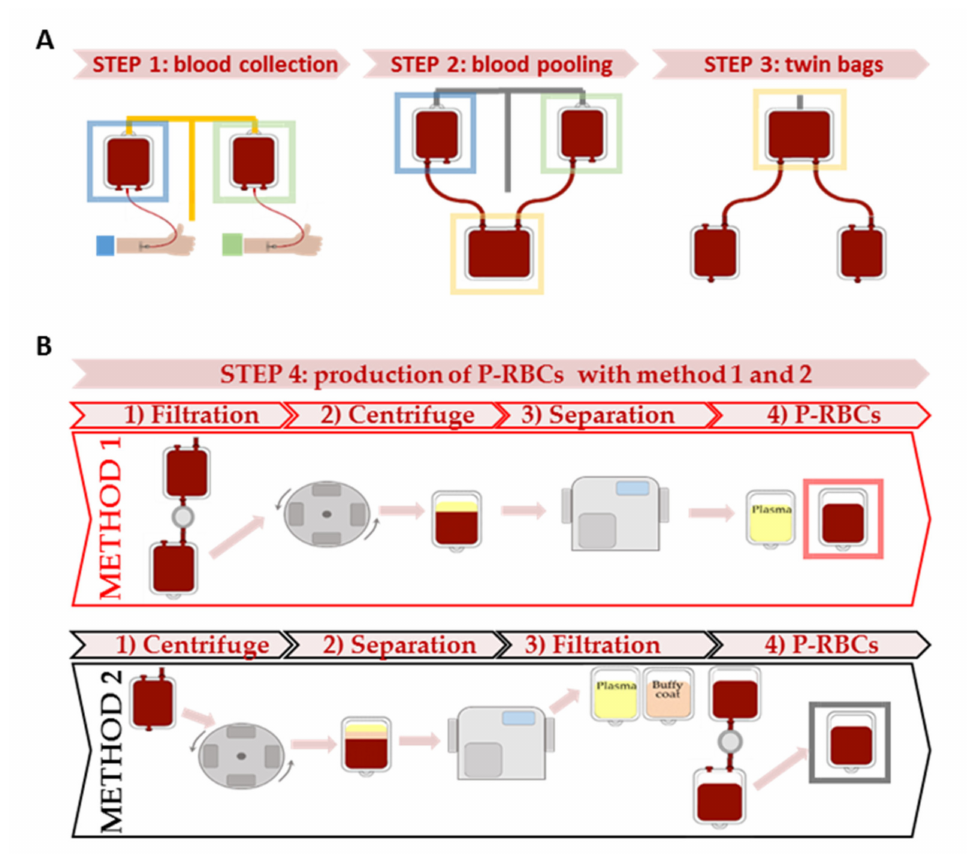
Figure 1. Scheme of experimental procedures. ( A ) in step 1 blood units are collected at day 0 from couples of donors with identical blood groups phenotype. Blood donors enrolled were 40, 20 from two different centers. In step 2, blood units from a couple of matched donors are pooled together in a transfer bag. In step 3, whole blood in the transfer bag was separated in 2 twin satellite bags. ( B ) in step 4 P-RBCs (red or black square) are prepared with method 1 or 2. The initial blood units are the two identical twin bags prepared in step